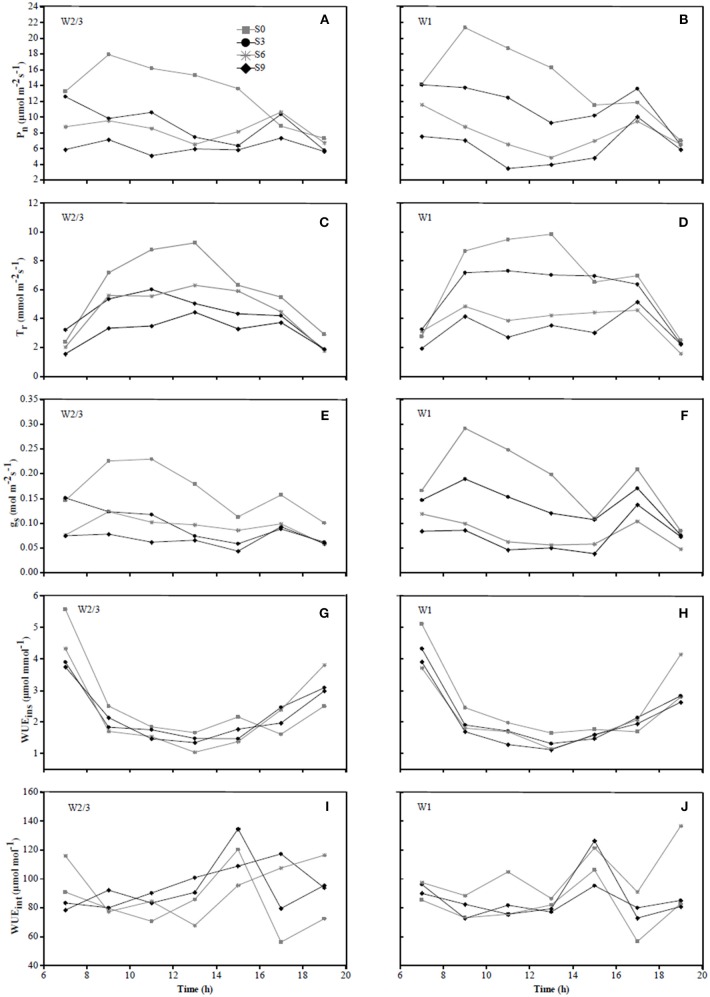
Diurnal variations in photosynthetic rate (Pn) (A,B), transpiration rate (Tr) (C,D), stomatal conductance (gs) (E,F), instantaneous water use efficiency (WUEins) (G,H), and intrinsic water use efficiency (WUEint) (I,J) of tomato under different water treatments at fruit ripening stage (date 07/22) in 2016.